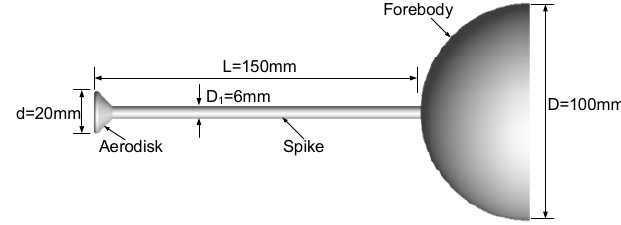
Figure 5. Typical spiked blunt body with an aerodisk.